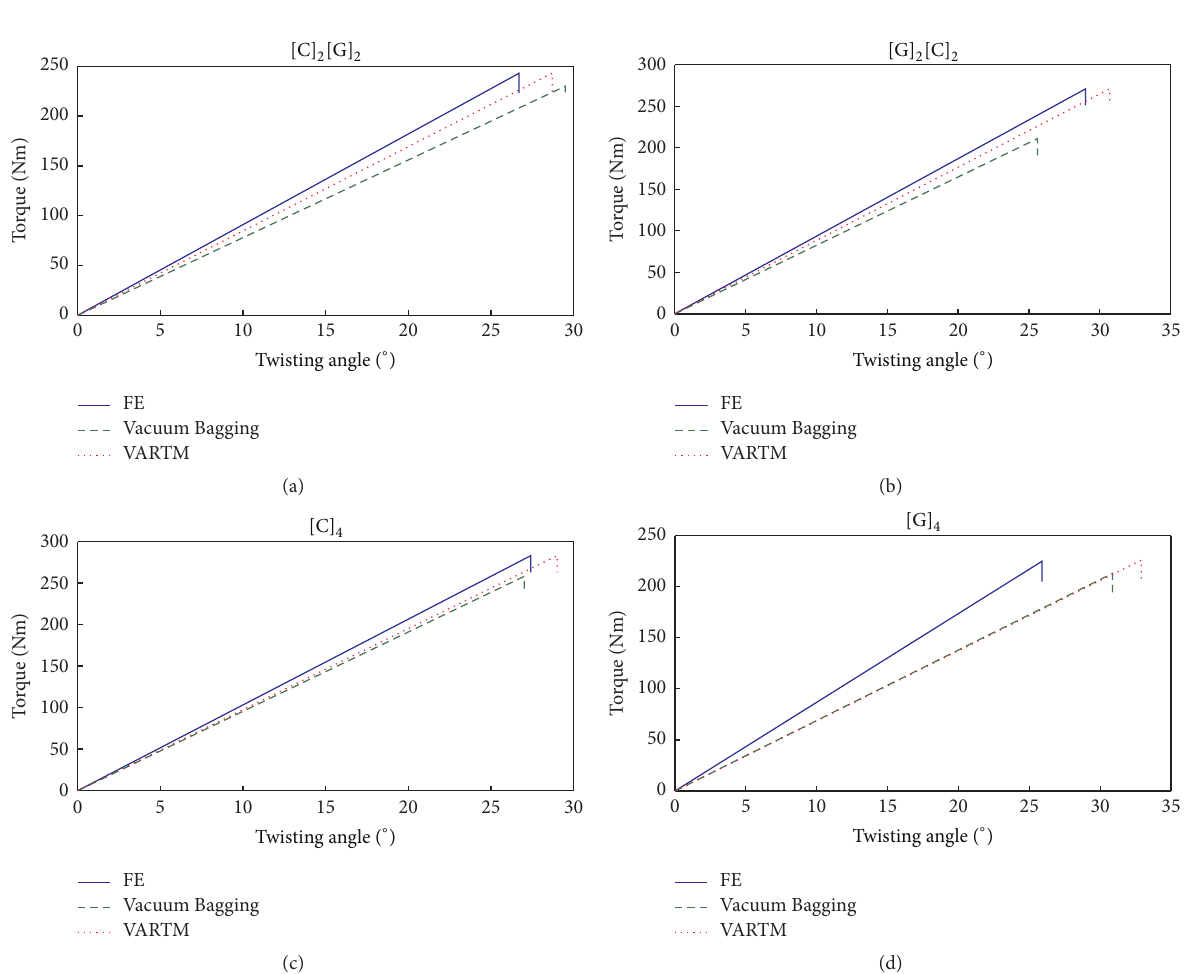
Figure 14: Comparison of the experimental results with FE analysis result. (a) [C] 2 [G] 2 sequence, (b) [G] 2 [C] 2 sequence, (c) [C] 4 sequence, and (d) [G] 4